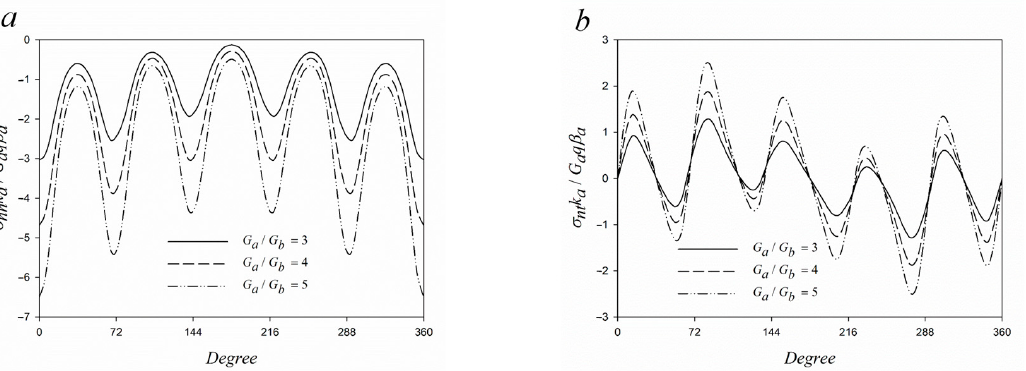
Figure 9. Interfacial ( a ) normal and ( b ) shear stress of a coated pentagonal hole ( w = 0.05 , β b / β b = 3 , k b /k a = 2 , ν b = 0.3 , ν a = 0.3).